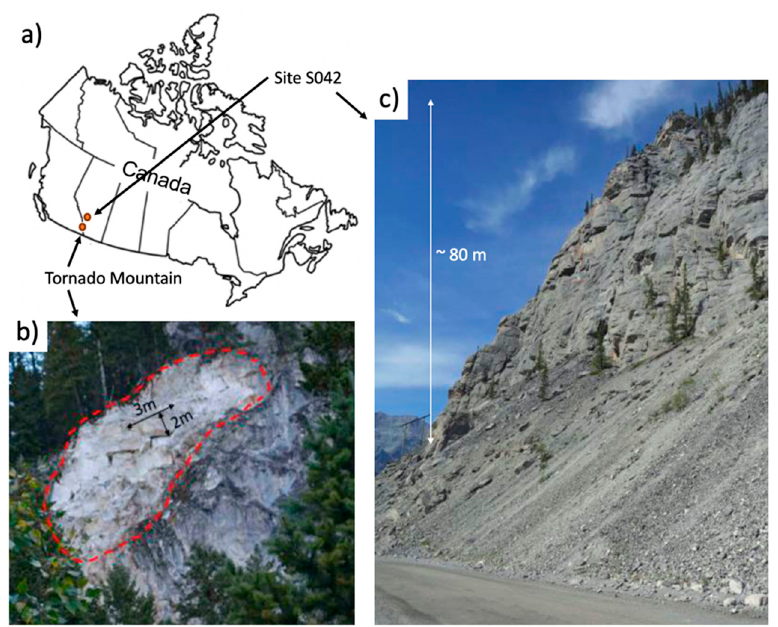
Figure 12. Location of the Tornado Mountain study site and S042 site ( a ). View of rock fall source at the Tornado Mountain site ( b ). View of the rock slope at S042 Site ( c ). Adapted from [55,56].